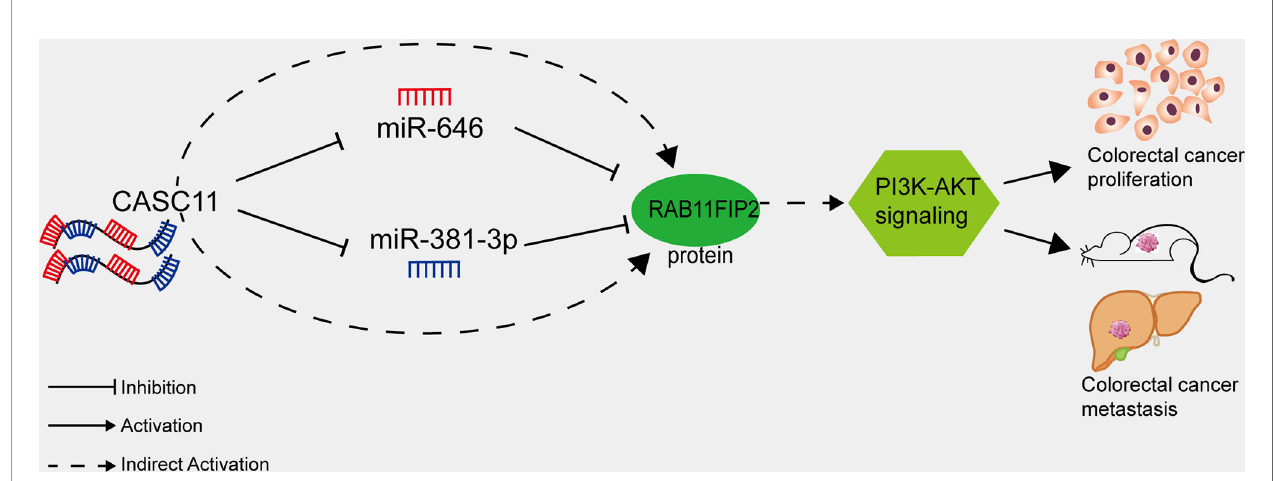
FIGURE 7 | Proposed model of how CASC11 regulates CRC proliferation and metastasis through the miR-646 and miR-381-3p/RAB11FIP2